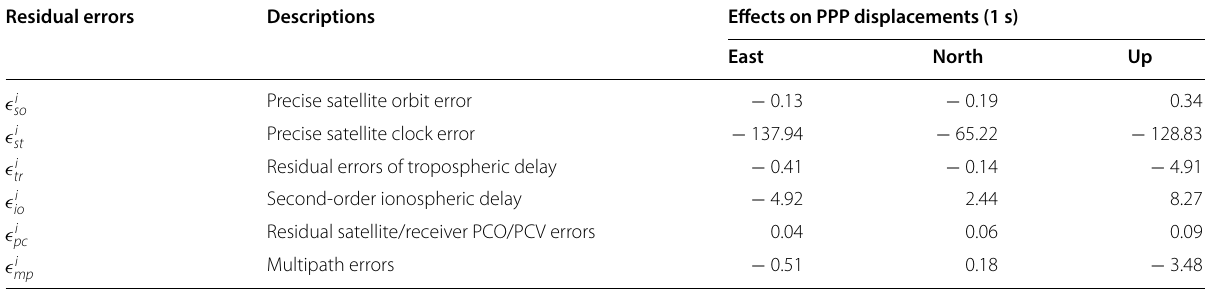
Table 2 Effects of residual systematic errors on PPP displacements within 1 s (units: 1.0E − 3 mm) Residual